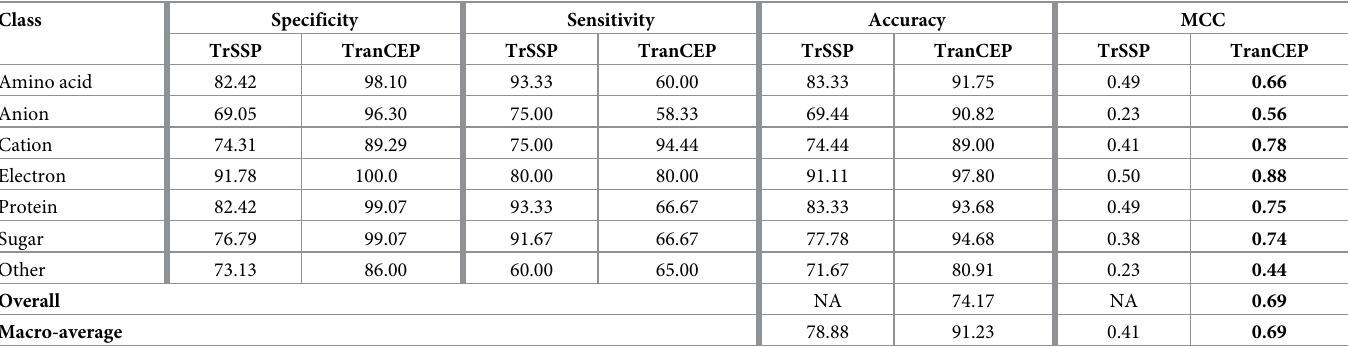
Table 5. Comparing TranCEP and TrSSP.